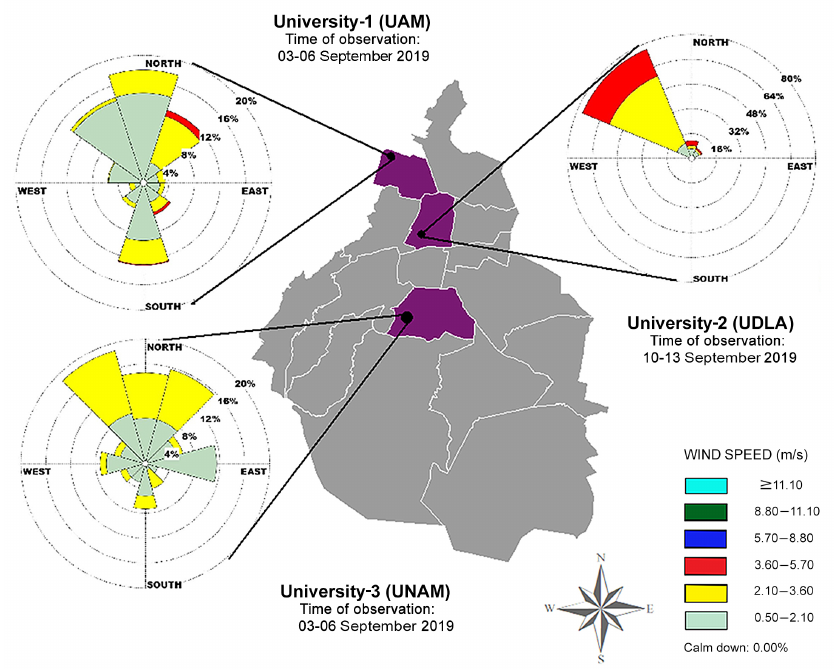
Figure 6. Wind roses summer sampling campaign: University-1 (UAM), University-2 (UDLA) and University-3 (UNAM).